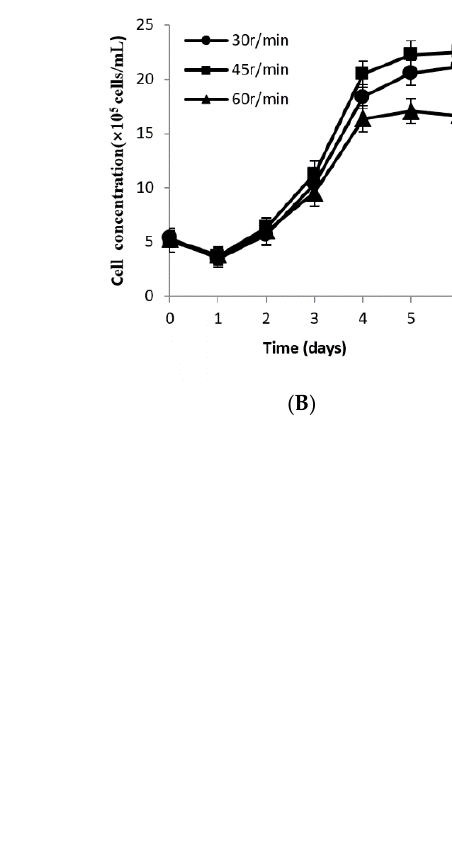
8 of 14 Figure 6. Growth curve of CPB cells at different expansion ratios. Bars show the mean ± SD, n = 3. When the expansion ratio was 1:2 and 1:3, cells reached the stable phase at the fourth day with a maximal concentration of 2.27 × 10 6 and 2.24 × 10 6 cells/mL, respectively. When the ratio was 1:4, cells proliferated relatively slowly, and it couldn ’ t grow to a monolayer